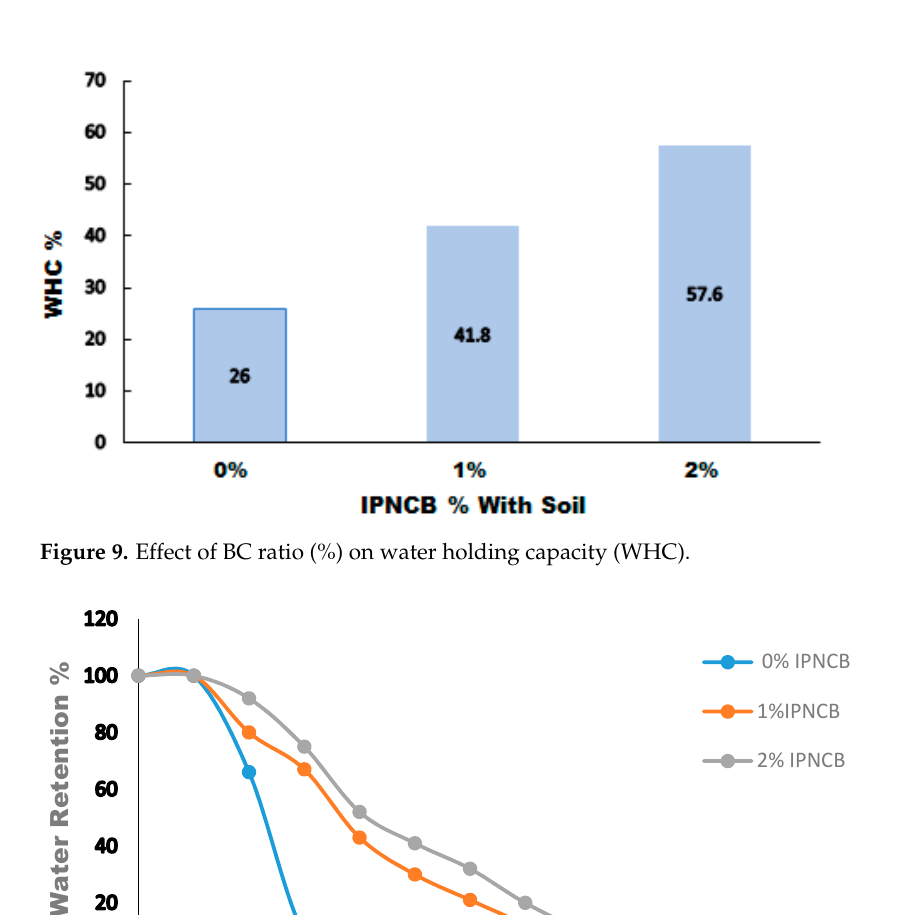
Figure 11. Degradation rate of IPNCB in the soil. The degradation of TerPolys (AA-co-Am-co-AMPS) and bonds in CMC structure [47] causes a decrease of crosslink density of the IPNCB composite, enabling breakdown of the composite with bacteria and enzymes in the soil. The degradation rate in the present work is in agreement with other studies that found comparable values for similar evaluation times [48], indicating that the IPNCB superabsorbent composite is degradable and could be applied in arid land and various agricultural applications.